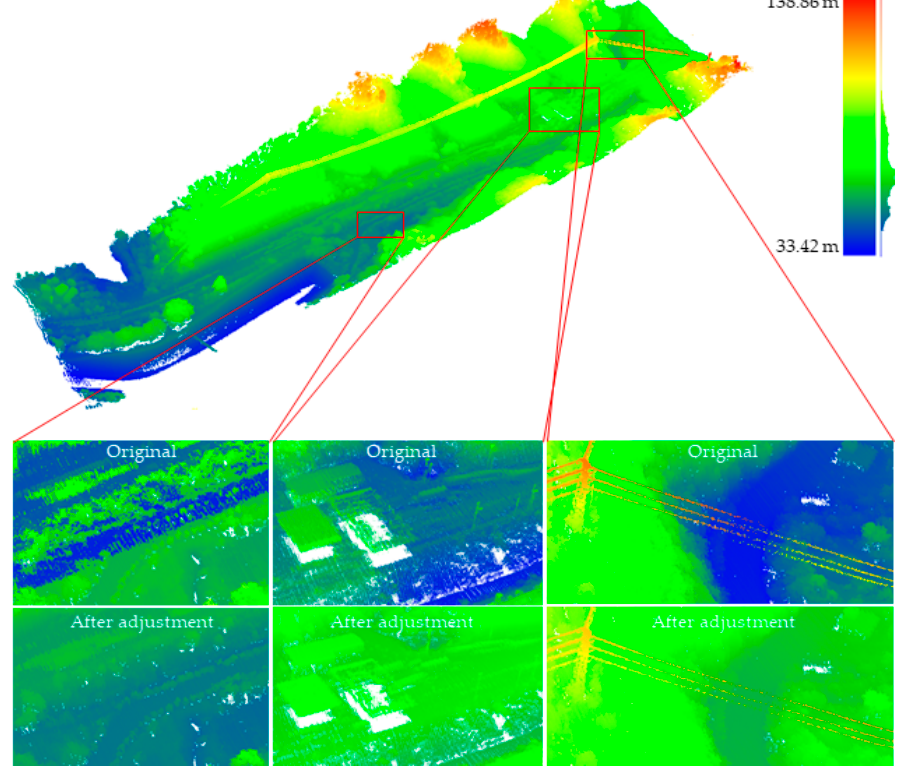
Figure 5. The result after strip adjustment and the comparison of some